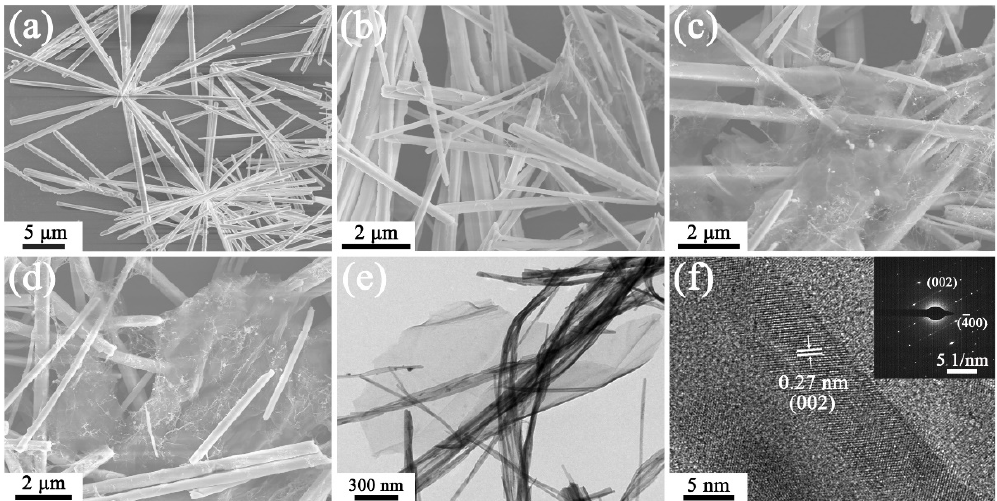
Fig. 1 SEM images of the as-prepared (a) α -AgVO 3 , (b) 0.5 GO/ α -AgVO 3 , (c) 1.0 GO/ α -AgVO 3 , and (d) 2.0 GO/ α -AgVO 3 , and (e) TEM image and (f) HRTEM image of 0.5 GO/ α -AgVO 3 (the inset image in (f) shows the corresponding SAED pattern).